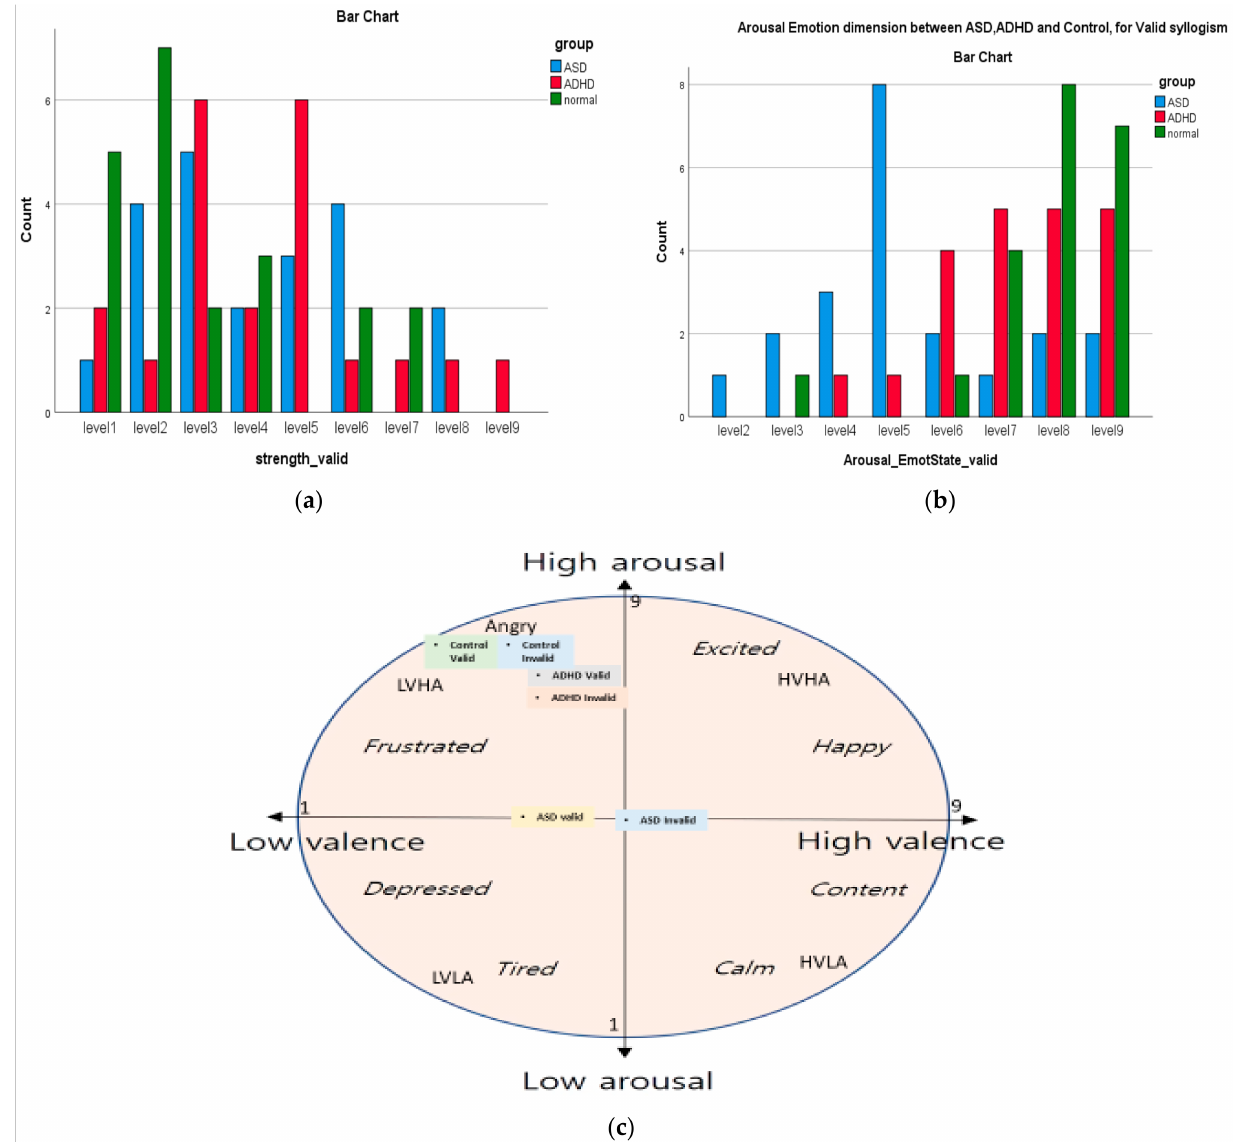
Figure 7. Variation of arousal ( a ) and valence (strength), ( b ) dimensions of emotion scores with groups, ( c ): 2-D plot of the arousal and valence (strength) dimensions of emotion scores, for the three groups [100,101]. The plot is based on the median values of Table